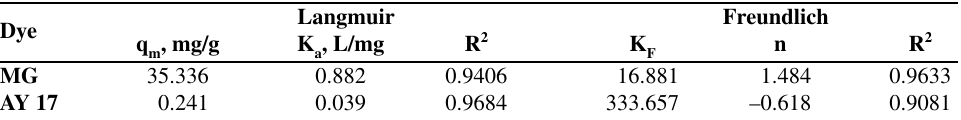
Gan et al.: Utilization of Corn Cob and TiO